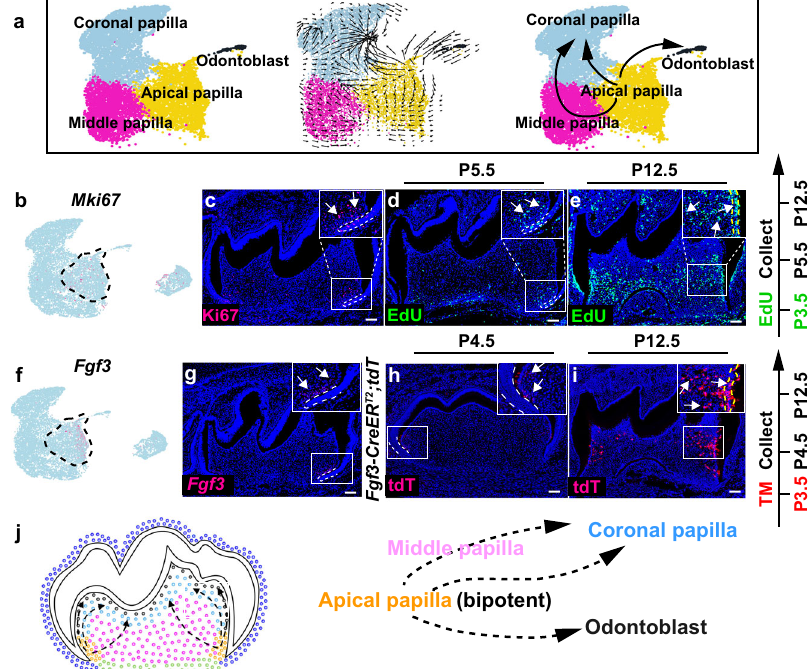
Fig. 5| Apicalpapillacellsarebipotent progenitorcellsthatgiveriseto dental pulp cells and odontoblasts in the mouse molar. a Velocity analysis of dental papilla cell populations in the mouse molar at P3.5. b , c Feature plot of Mki67 and immunostainingofKi67inthemousemolaratP3.5( n =3). d , e EdUtracinganalysis in the mouse molar from P3.5 to P12.5 ( n =3). f , g Feature plot and RNAscope staining of Fgf3 in the mouse molar at P3.5 ( n =3). h , i Lineage tracing analysis of Fgf3+cellsinthemousemolarfromP3.5toP12.5( n =3). j Differentiationtrajectory